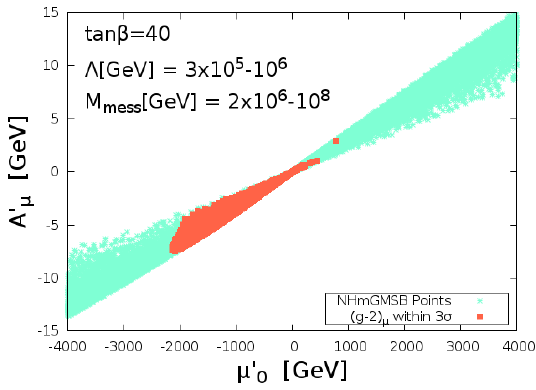
Figure 6 . Scatter plot of (cid:22) 0 vs A 0 where (cid:3) and M mess are varied according to the ranges mentioned (cid:22) 0 in eqs. (3.2). The green points satisfy all the relevant constraints of eq. (3.3) while the orange points correspond to a region that satisfy the muon g (cid:0) 2 constraint at 3 (cid:27)